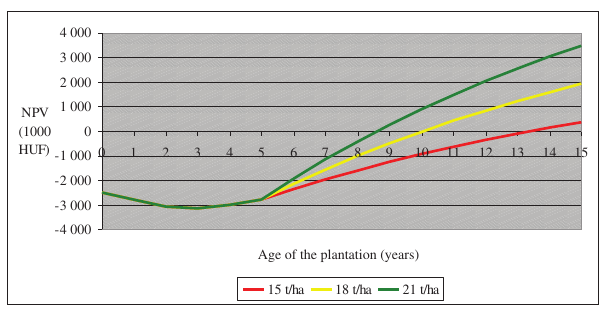
Figure 2 – Calculation of returns as a function of yields at the same prices (yearly 25% damages calculated as a realistic risk)